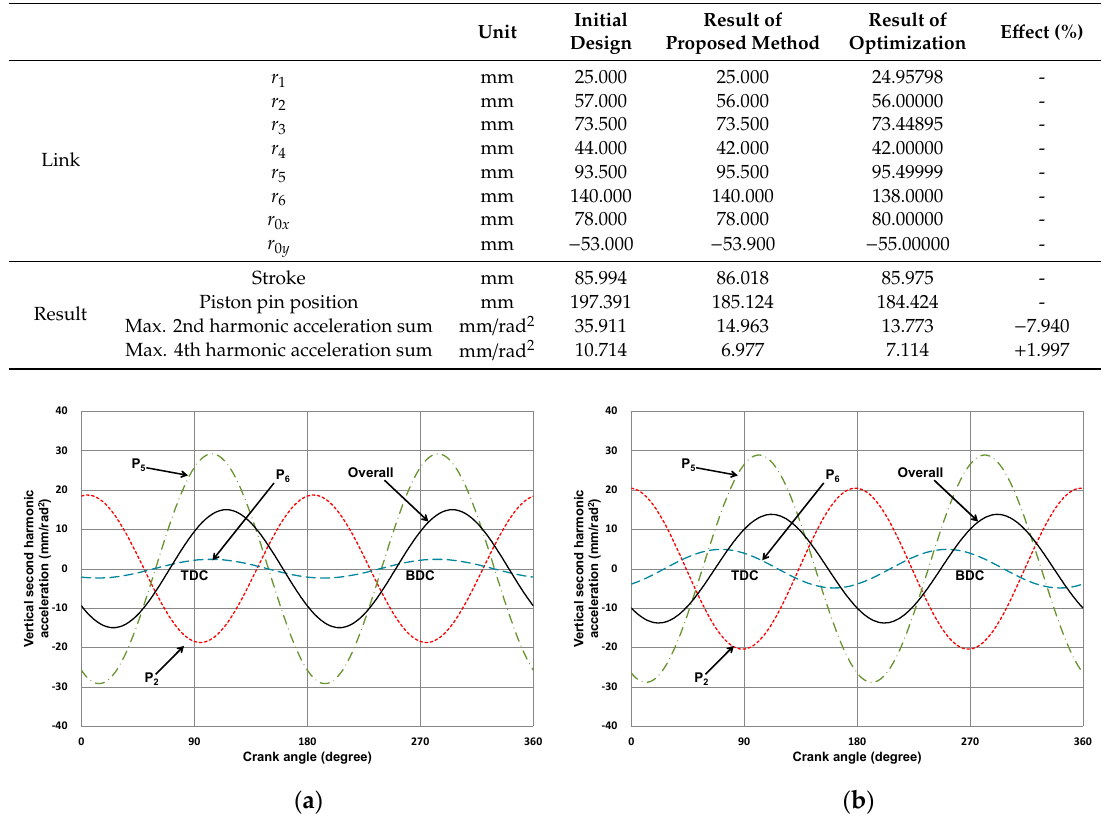
Table 8. Comparison of the results of the proposed method and the constrained optimization.